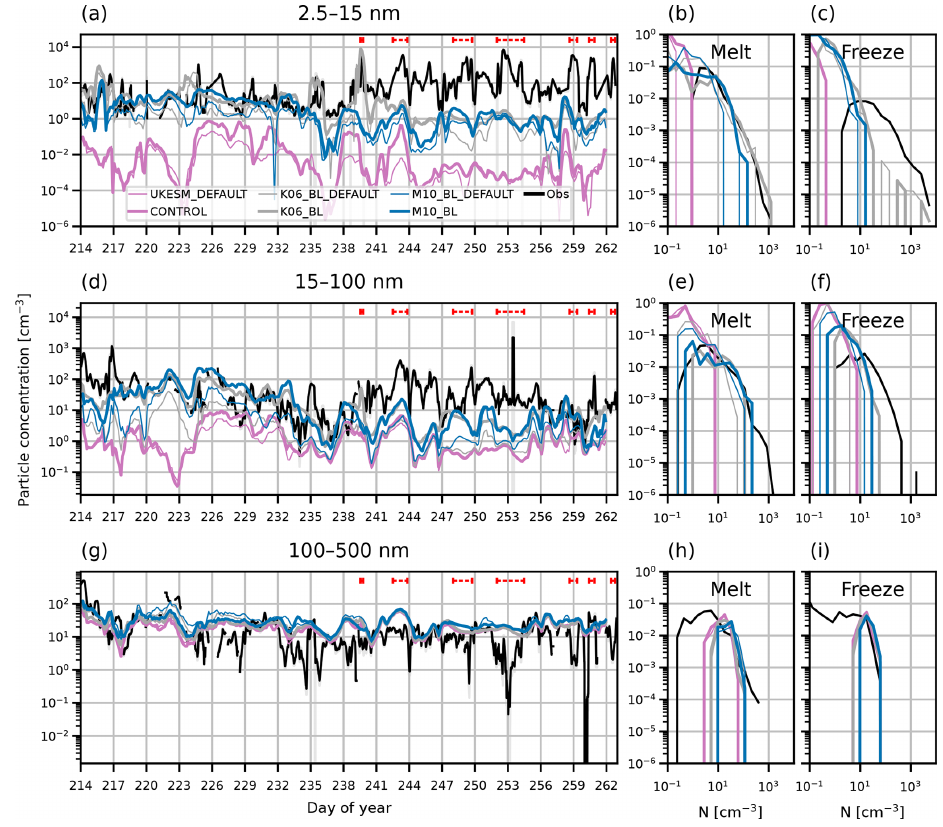
Figure C1. Time series and PDFs of surface aerosol concentration during AO2018 from observations and model output. Model output is from simulations UKESM_DEFAULT (thin pink lines), CONTROL (thick pink lines), SA_DEFAULT (think grey lines), SA (thick grey lines), SOA_DEFAULT (thin blue lines), and SOA (thick blue lines). Observations are shown as 3-hourly mean (black lines) and standard deviation (grey shading). Aerosol concentrations are shown for particles with diameter (a–c) 2.5–15nm, (d–f) 15–100nm, and (g–i) 100–500nm. Dashed red lines in (a) , (d) , and (g) show observed NPF events. PDFs are separated by observed sea ice freeze-up date, 27 August 2018 (day